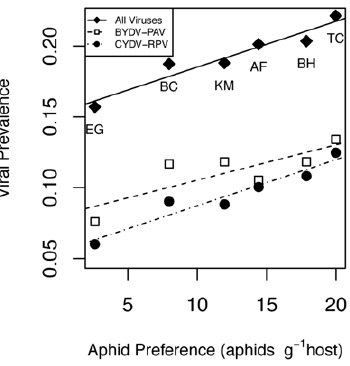
Figure 2. Correlations of an aphid vector ( Rhopalosiphumpadi )’s feeding preference with the B/CYDV prevalence. Plot show overall B/CYDV prevalence (infection by any virus) and the prevalences of two viruses (BYDV-PAV and CYDV-RPV) vectored by R. padi . The six grass hosts are as follows: Avena fatua (AF), Bromus carinatus (BC), Bromus hordeaceus (BH), Elymus glaucus (EG), Koeleria macrantha (KM), and Taeniatherum caput-medusae (TC). Correlations between feeding preference and overall prevalence of infection (r=0.96), BYDV-PAV (r=0.82), and CYDV-RPV (r=0.96) were significantly greater than 0 (p ,